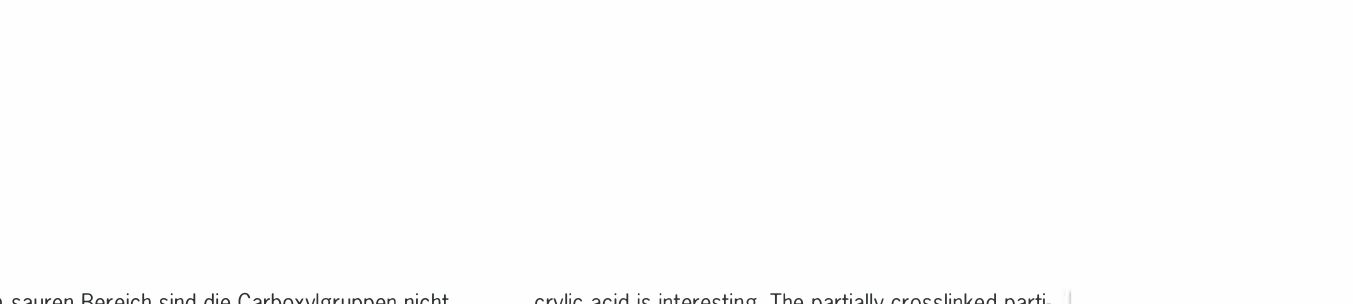
Fig. 6: Phase displacement during oscillating shear